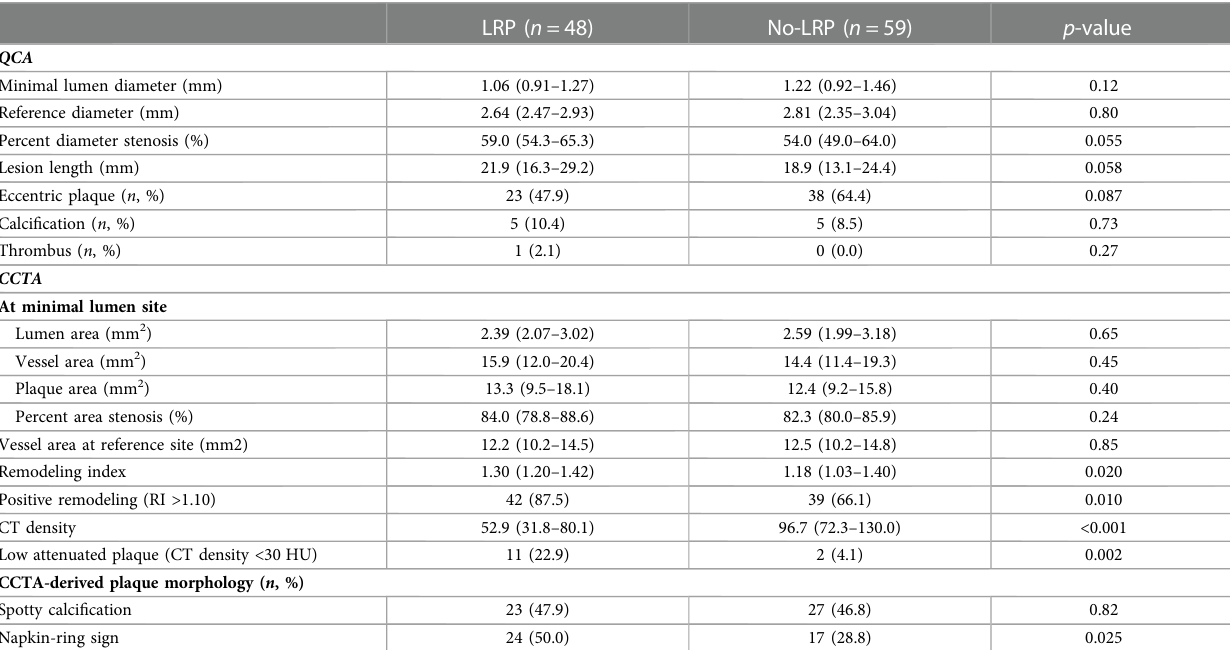
TABLE 2 QCA and CCTA analysis at